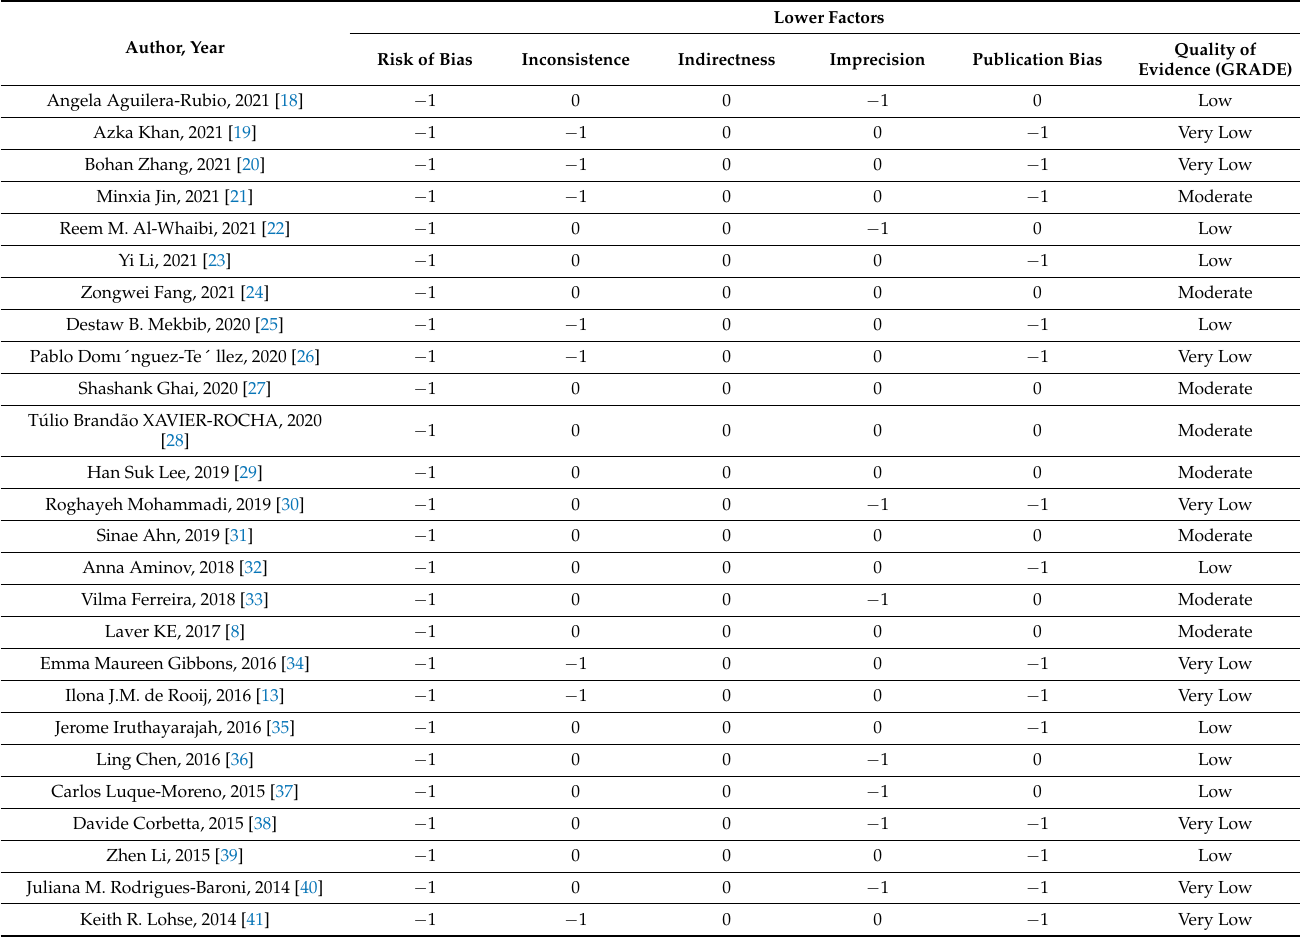
Table 4. Results of the Grading of Recommendations Assessment, Development, and Evaluation system (n = 26).